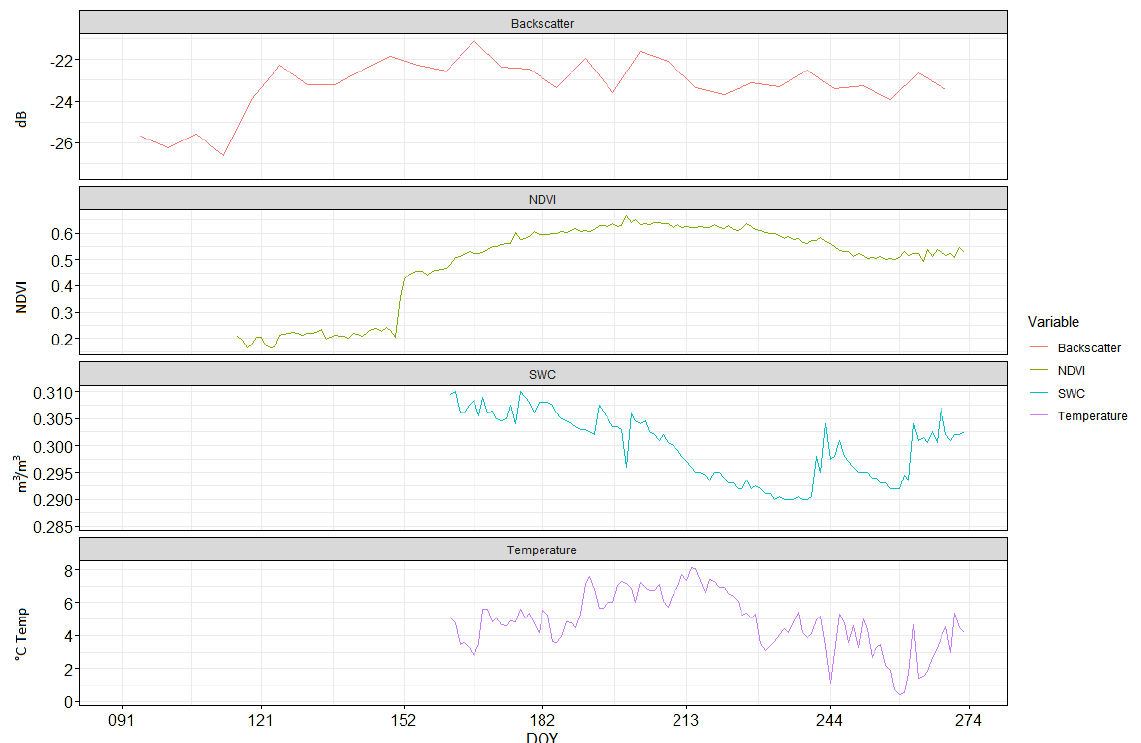
Figure 9. Time series of S-1 HV channel and ground sensors for the area ST3 2017: in the graphs, in red is shown the HV backscatter, in green the NDVI, in blue the Soil Water Content (SWC) and in purple the soil temperature at 10 cm depth. A moving average filter was applied to the time